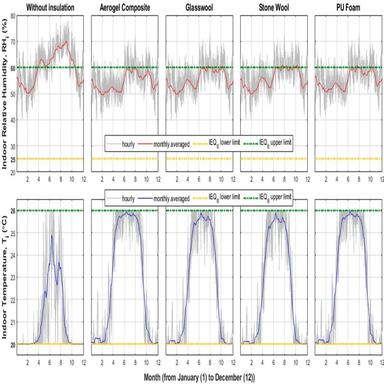
Indoor Relative Humidity RHi and Temperature Ti for the simulated building with masonry walls using aerogel composite, reference materials and original construction.